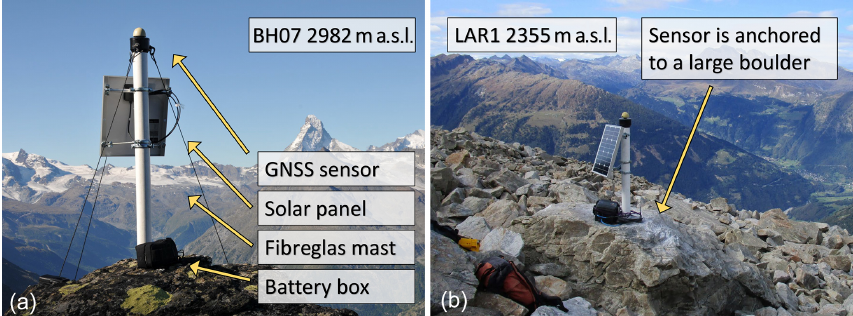
Figure 3. Two GNSS stations mounted atop large boulders on the Breithorn landslide 2982ma . s . l . , Herbriggen (a) and on the Largario Rock